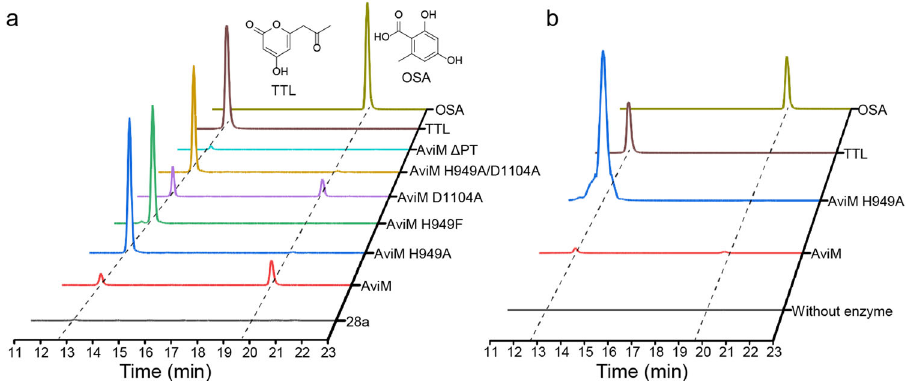
Fig. 2 In vivo and in vitro assays of AviM-catalyzed OSA biosynthesis. a E. coli K207-3 expressing AviM synthesizes OSA. Mutating the catalytic H949 abolishes OSA production, but results in TTL from spontaneous O-C cyclization of the ACP-bound tetraketide backbone. Mutating D1104 slightly increases TTL production. The product pro fi le of H949A/D1104A double mutant is similar to that of H949A mutant. Deletion of PT domain from AviM abolishes OSA production whereas a small amount of TTL is still generated. b OSA is produced when AviM is incubated with acetyl-CoA and malonyl-CoA in vitro, while TTL is produced by AviM mutant. The traces show the extracted ion counts (m/z: 167.0350) monitored in the negative Table 1 Data collection and re fi nement statistics.